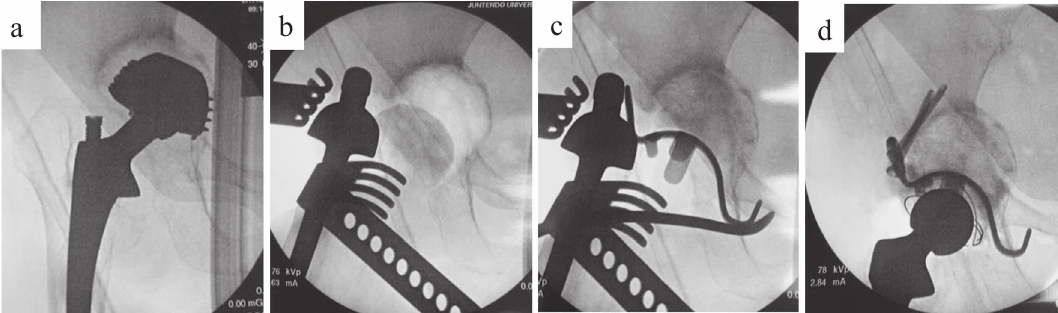
Figure 3. (a, b) For bone defects in the weight-bearing region of the hip joint, allogenic femoral head was trimmed, and temporary fi xation with it as bulk bone was applied using Kirschner wire. (c) After con fi rming that the KT plate was placed at an appropriate position, the retractor was set on the hook, and the plate was fi rmly pressed and attached to the tear drop. (d) A polyethylene liner with an optimum size was fi xed with